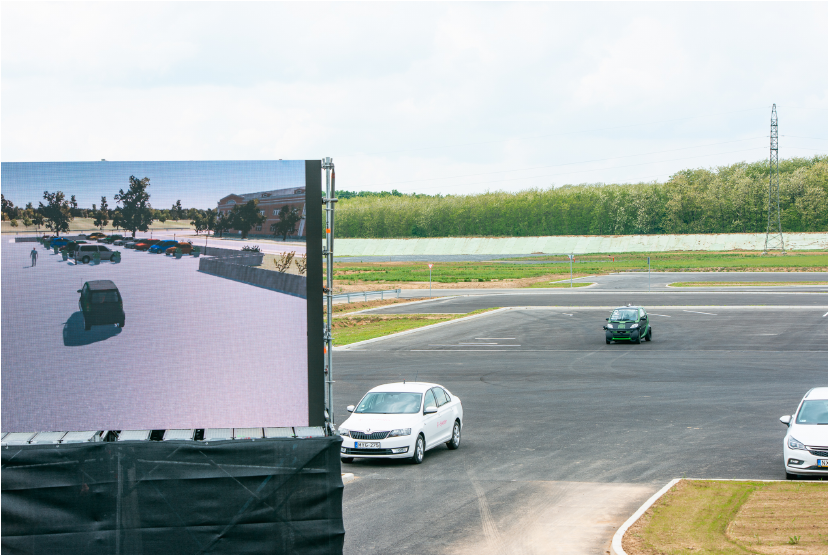
Figure 3. The VUT and the virtual